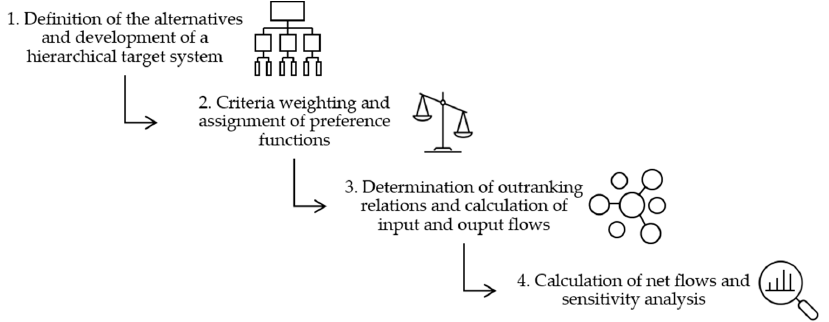
Figure 2. Establishment of the methodology for the systematic selection of a marking agent for a material marking in SLS. a material marking in